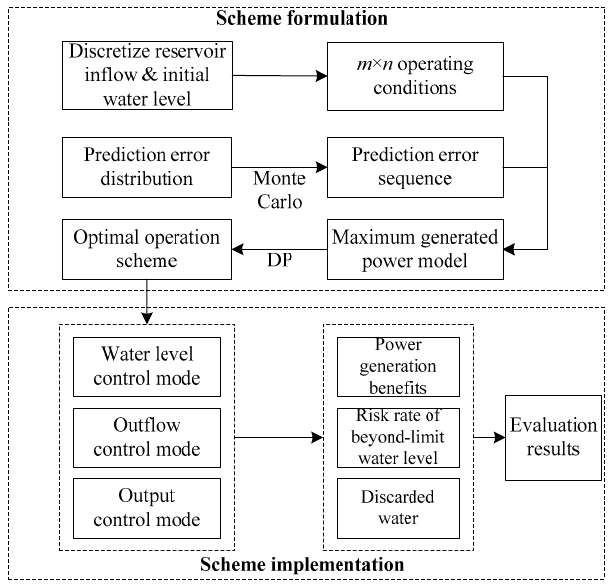
Figure 1. Calculation flow chart.